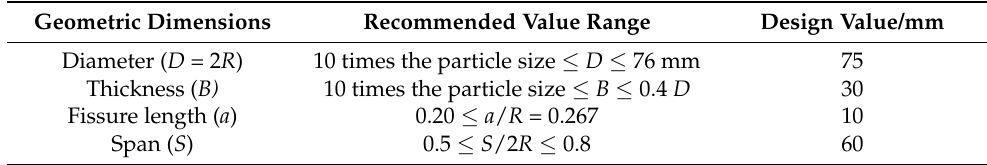
Figure 4. Specimen geometry and ligament surface. Table 1. NSCB specimen geometry specifications.